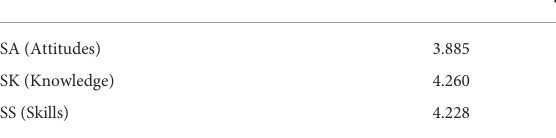
TABLE 4 Lateral collinearity of the latent